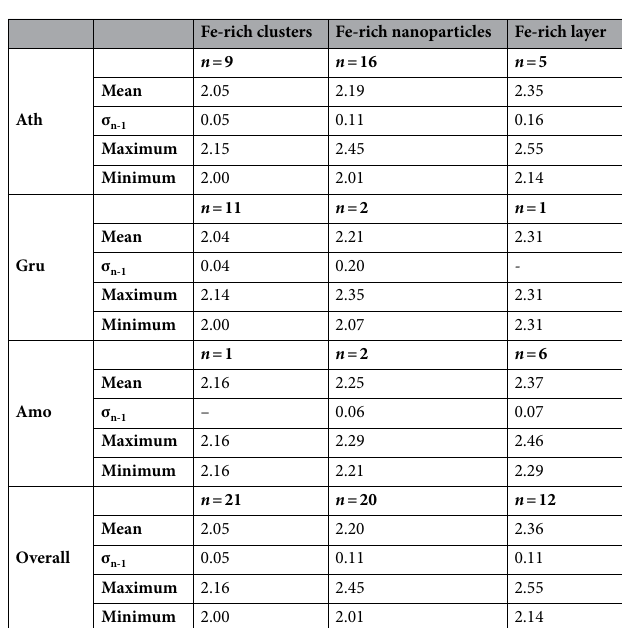
Table 5. Average Fe-valence state of Fe-rich clusters, nanoparticles, and amorphous layer grown during the interaction with AECs, as determined by acSTEM Dual-EELS investigations.